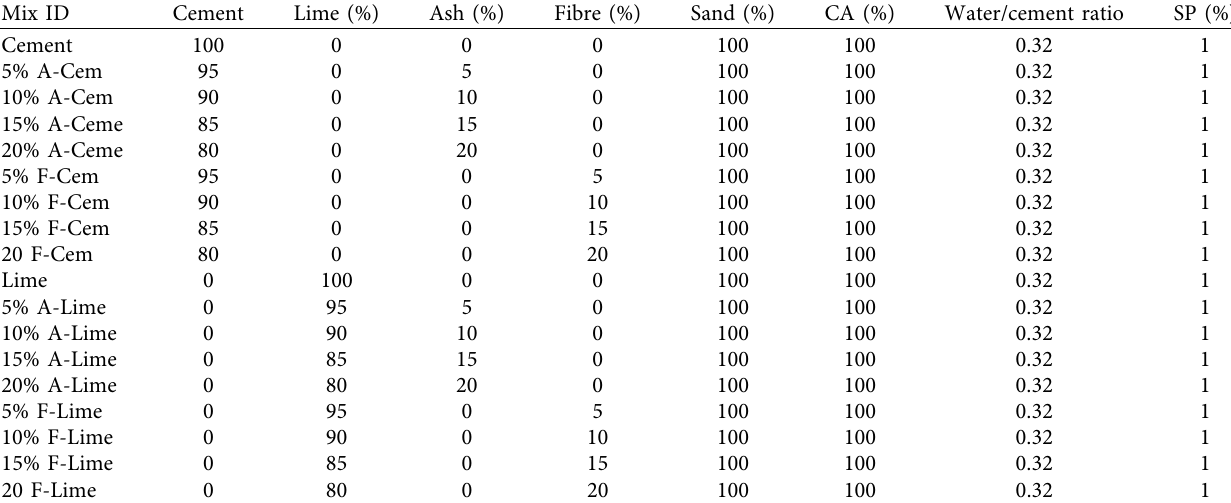
Table 2: Mix proportions of